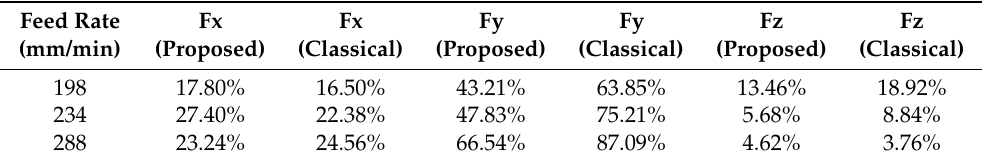
Table 6. Relative error of different feed rates.